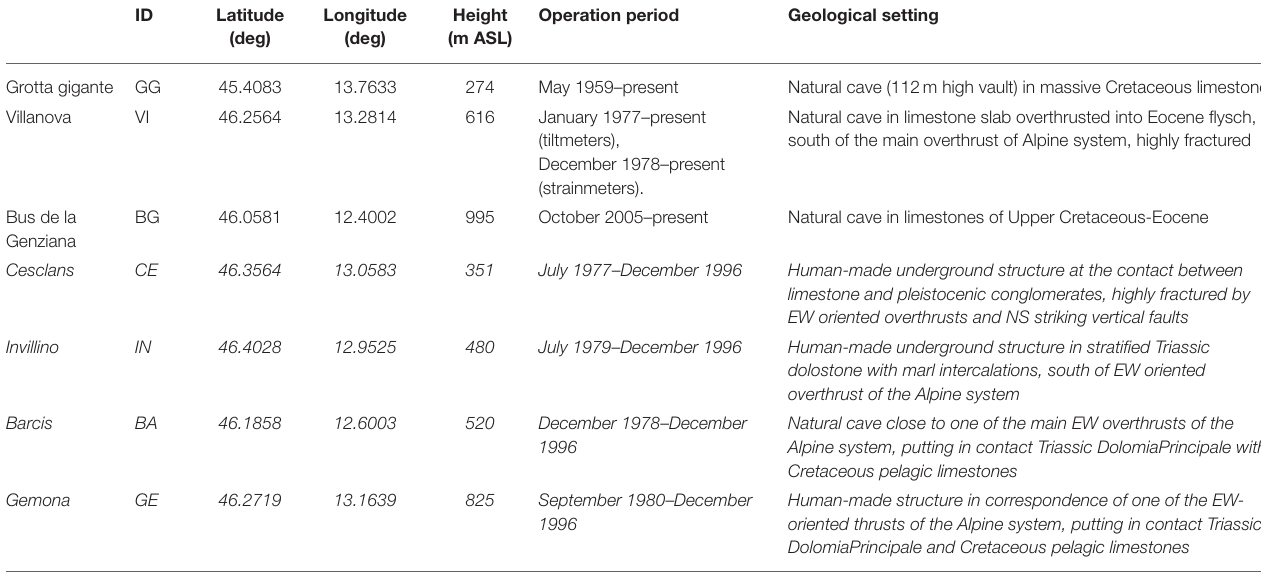
TABLE 1 | Site characteristics of the NE-Italy subsurface tilt-strainmeter network; in italic, the stations that are not presently active.